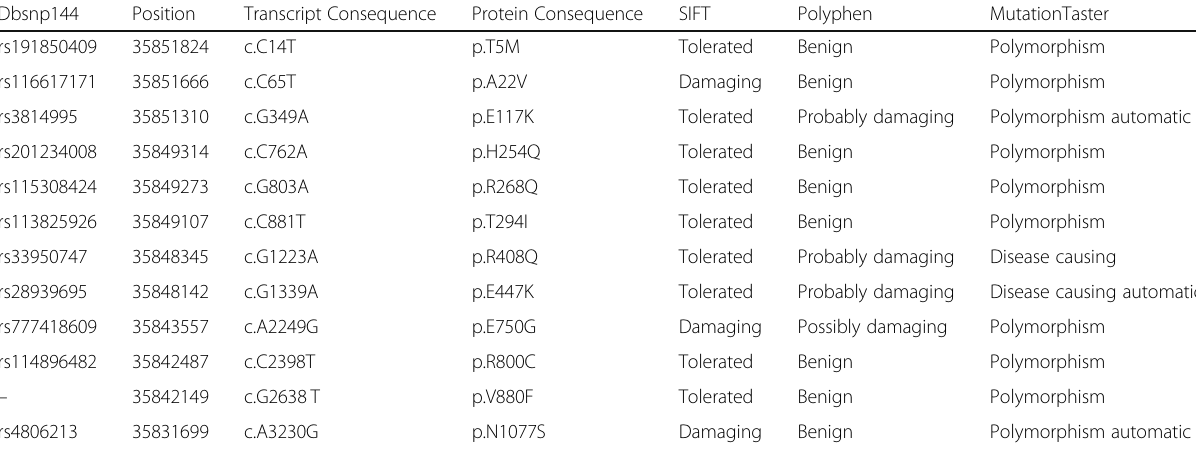
Table 4 Pathogenicity predicted by three software for the non-synonymous mutations